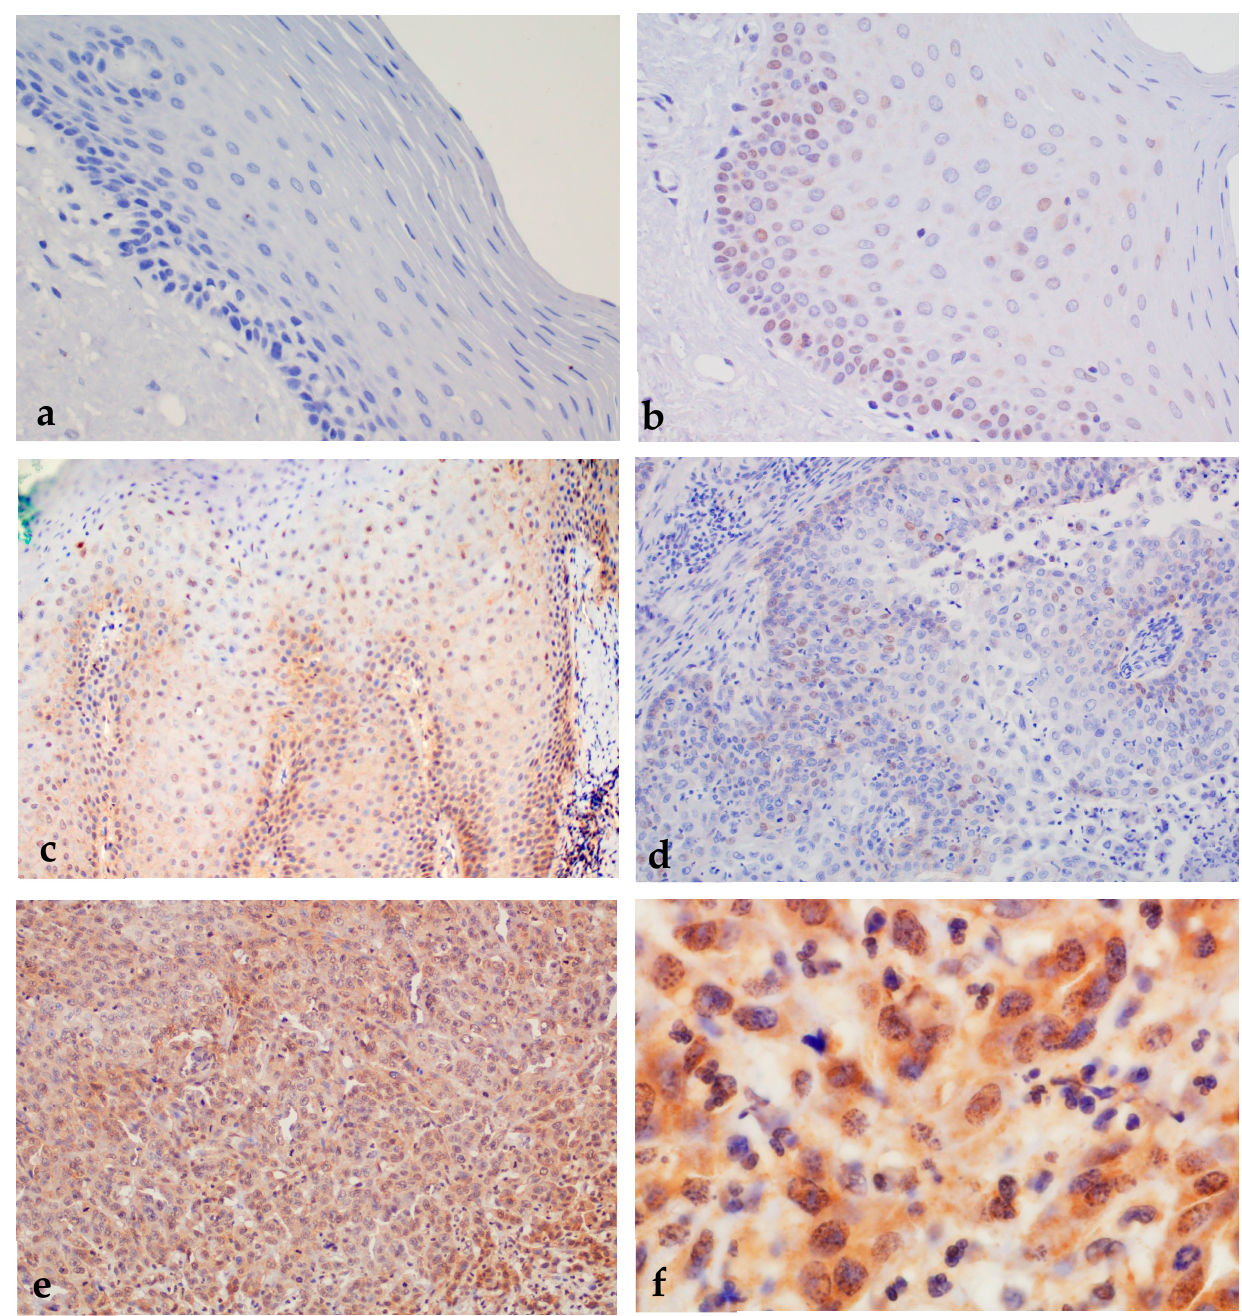
Figure 11. Immunohistochemical expression of nEGFR in healthy oral mucosa, oral premalignant changes, and OSCCs. ( a ) Negative immunohistochemical expression of nEGFR in healthy oral mucosa. Magnification 200 × . ( b ) Oral leukoplakia with moderate dysplasia and weak expression of nuclear EGFR (+). Magnification 400 × . ( c ) Oral erythroplakia with moderate expression of nuclear EGFR (++). Magnification 200 × . ( d ) Weak expression of nEGFR in well-differentiated OSCC (+). ( e ) Strong nuclear staining for nEGFR in more than 35% of cells in moderately differentiated OSCC (+++). Magnification 200 × . ( f ) Strong immunohistochemical staining for nEGFR in the nucleus and moderate staining for EGFR in the cytoplasm of OSCC. Magni fi cation 1000×. When the frequency of nEGFR expression was compared between the studied groups, a statistically signi fi cant di ff erence was found in the expression of nEGFR in the di ff erent groups. The frequency of moderate (++) and strong nEGFR expression (+++) was signi fi cantly higher in the group of patients with OSCC and premalignant changes than